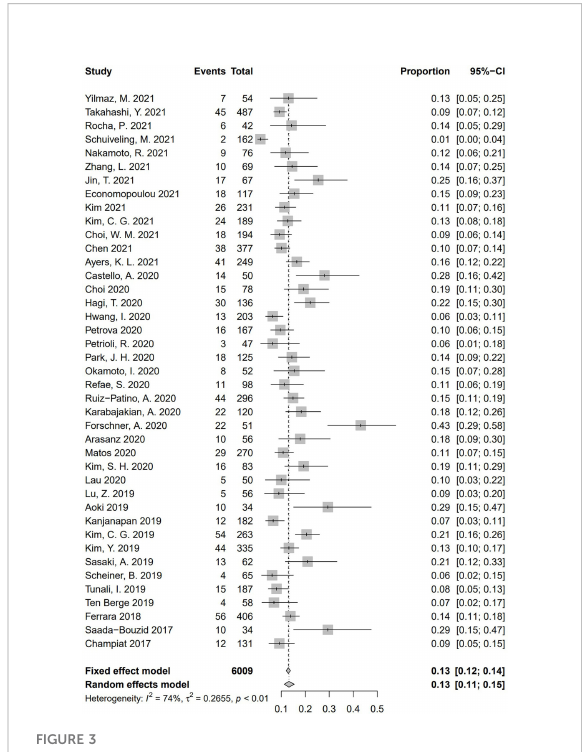
funnel plots and Egger ’ s tests (for Egger ’ s test, LDH: P = .80;